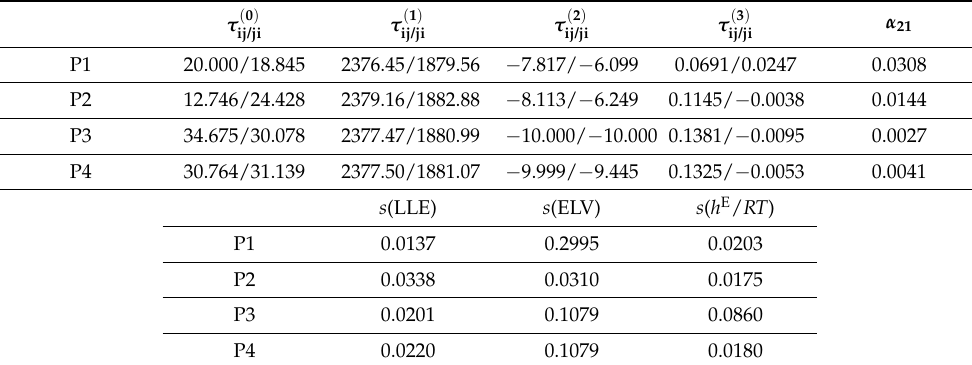
Table 3. Parametrizations of the NRTL using the MOP to model the methyl methanoate (1) + pentane (2) system.